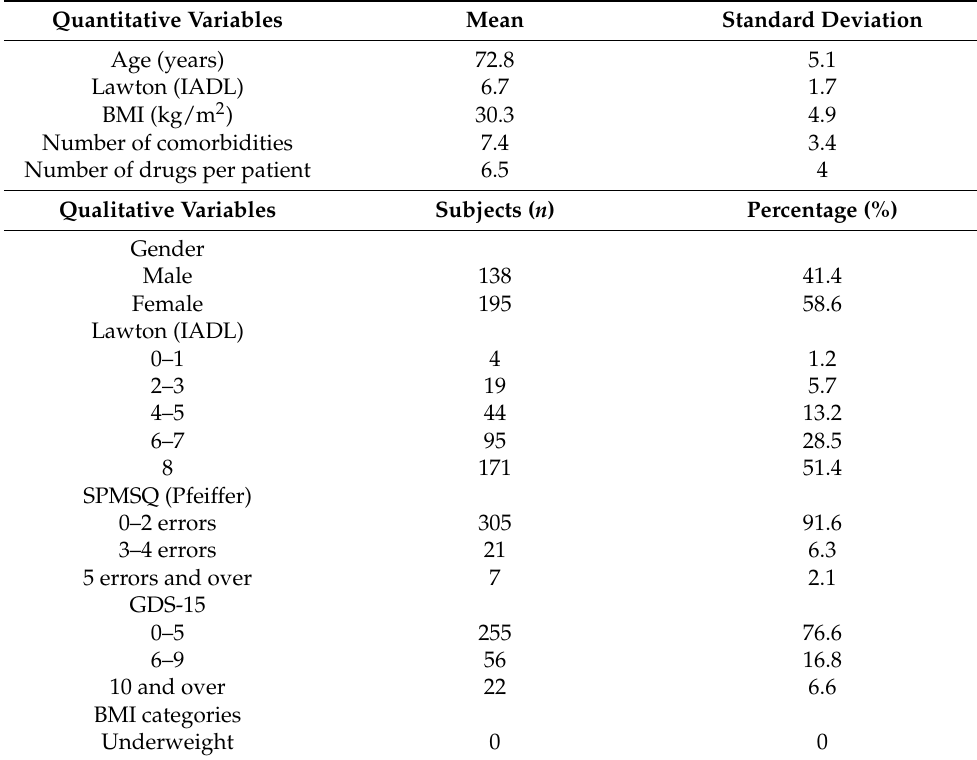
Table 1. Characteristics of the study population ( n =